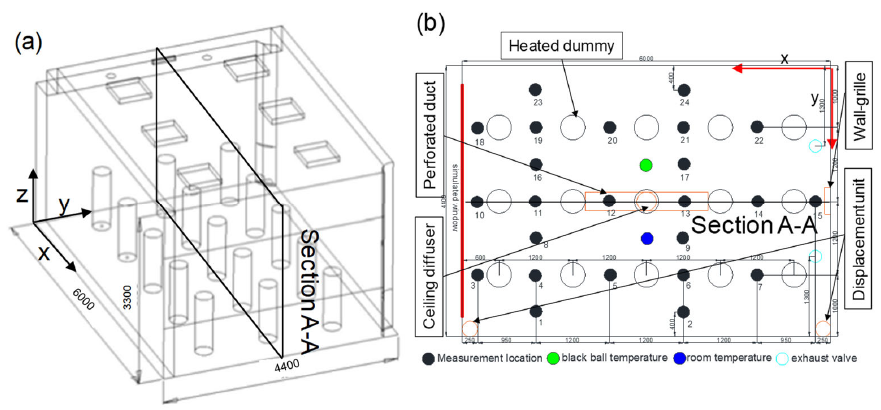
Figure 2. Full ‐ scale experiment. ( a ) Set ‐ up of half ‐ size classroom and ( b ) measured points in the test Figure 2. Full-scale experiment. ( a ) Set-up of half-size classroom and ( b ) measured points in the chamber. test